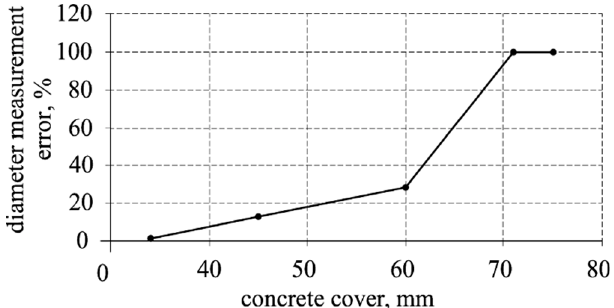
Figure 1. The error of the reinforcement diameter measured with an electromagnetic device, depending on the cover size according to